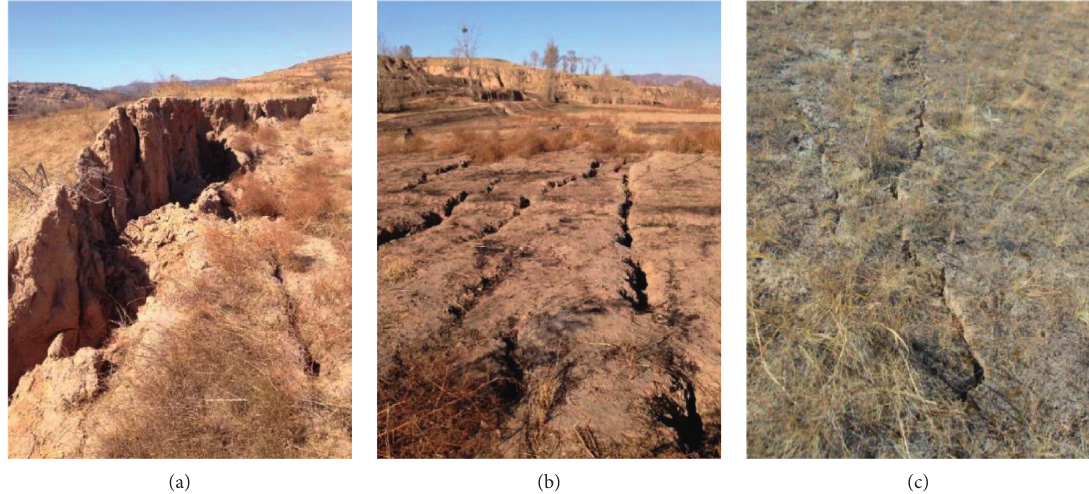
Figure 4: Morphology of surface cracks in loess-covered area. (a) Surface cracks near the boundary of goaf (main crack). (b) Crack right above the middle of goaf. (c) Crack near the surface movement basin